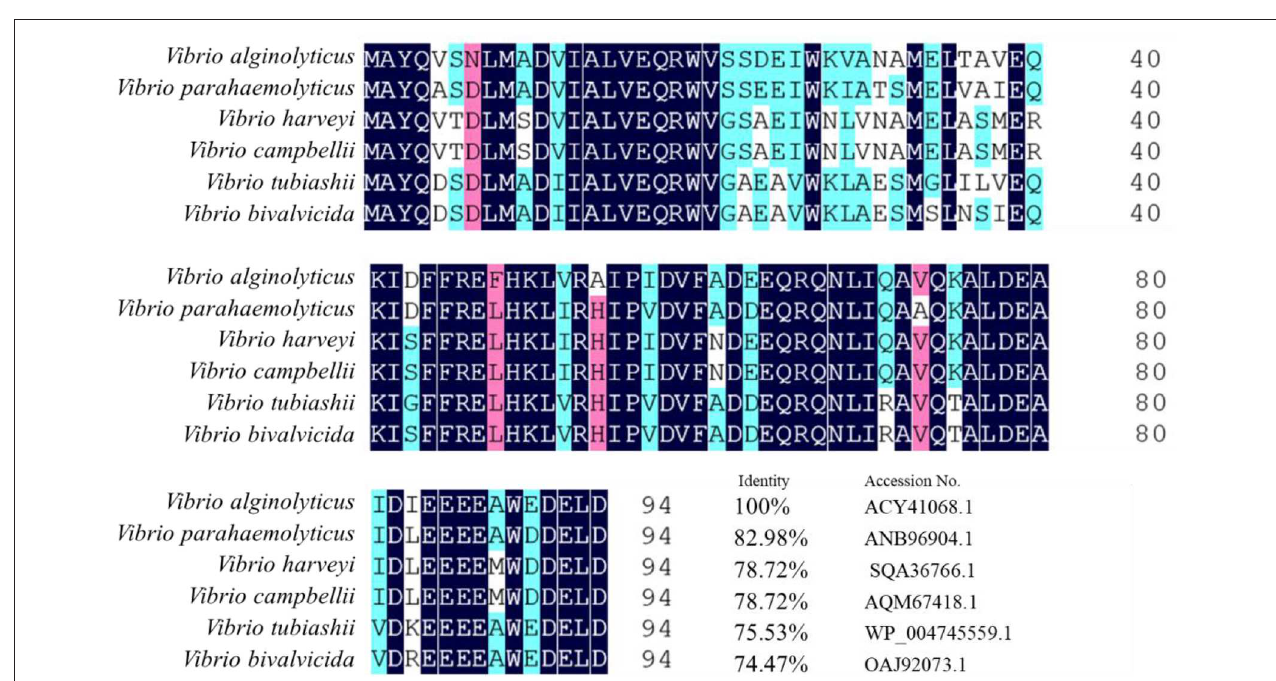
FIGURE 2 | Homology comparison of Vibrio parahaemolyticus HY9901 T3SS Regulator Protein TyeA. Vibrio alginolyticus T3SS regulatory protein TyeA Accession No.ACY41068.1; Vibrio parahaemolyticus T3SS regulatory protein TyeA Accession No.ANB96904.1; Vibrio harveyi T3SS regulatory protein TyeA Accession No.SQA36766.1; Vibrio campbellii T3SS regulatory protein TyeA Accession NO.AQM67418.1; Vibrio tubiashii T3SS regulatory protein TyeA Accession No.WP_004745559.1; Vibrio bivalvicida T3SS regulatory protein TyeA Accession No.OAJ92073.1.